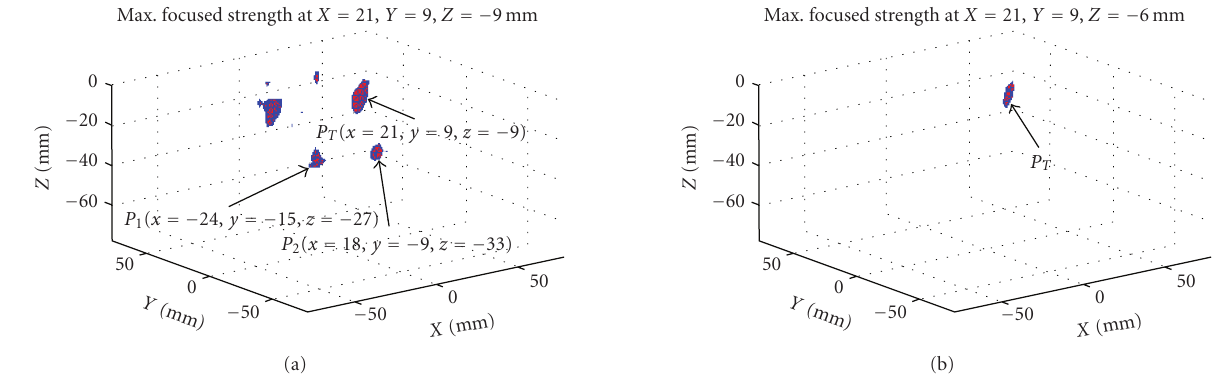
Figure 6: Detection results of a 7 mm spherical phantom tumour: (a) standard DAS, (b) improved DAS with QF = a . 3D figures present − 3 dB contour map of scattered